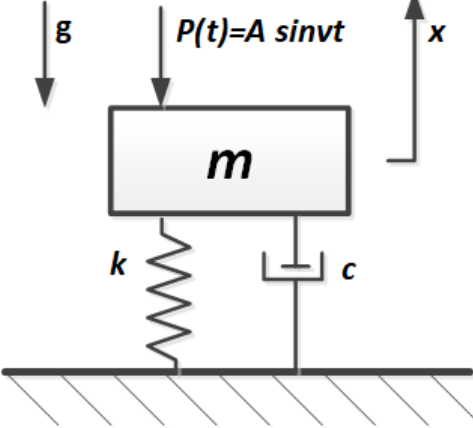
Figure 1. System of the shock absorber.